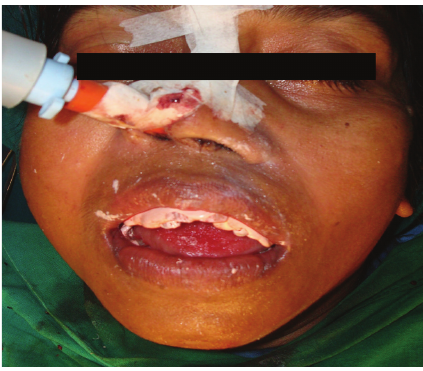
Figure 7: Patient at the end of the surgery and after the pack placement.